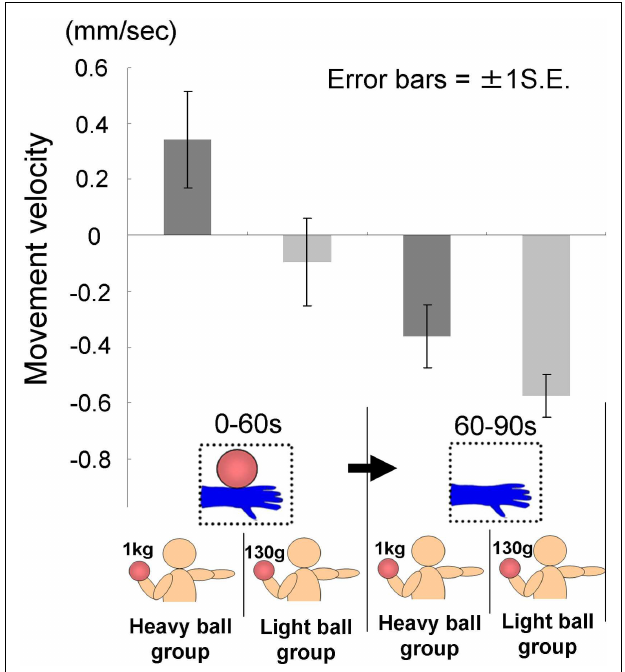
FIGURE 6 | Movement velocity in each group in Experiment